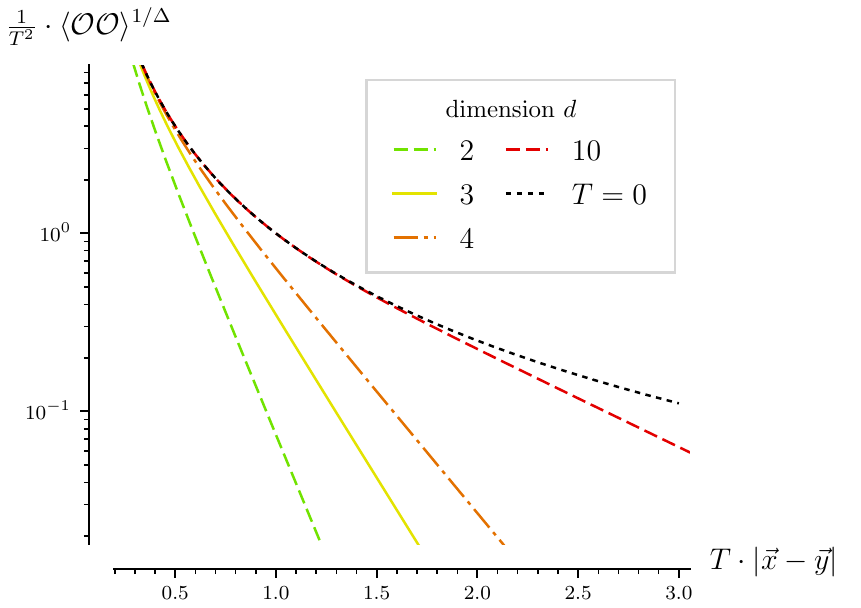
Figure 4. Two-point function for di(cid:11)erent spacetime